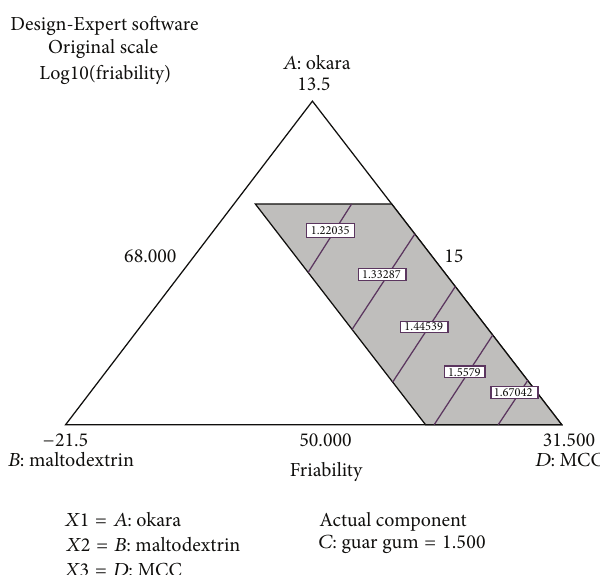
Figure 3: Contour diagram of relationship between three variables, ( 𝐴 ) percentage of okara, ( 𝐵 ) percentage of maltodextrin, and ( 𝐷 ) percentage of Avicel PH-101, and with actual component of guar gum ( 𝐶 = 1.50 %) to the friability of the